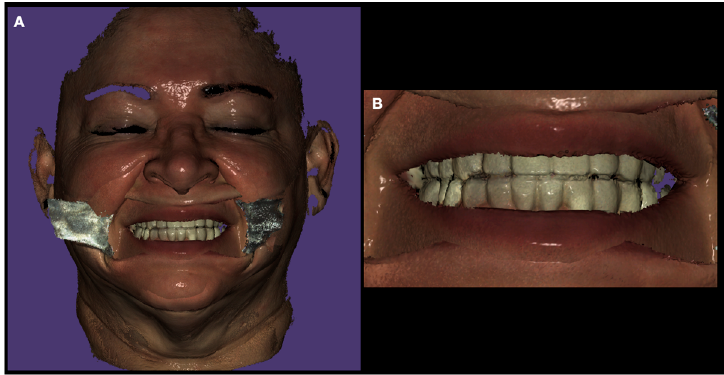
Figure 2. Initial face scan. ( A ) extra-oral smiling. ( B ) Close-up of the smile.